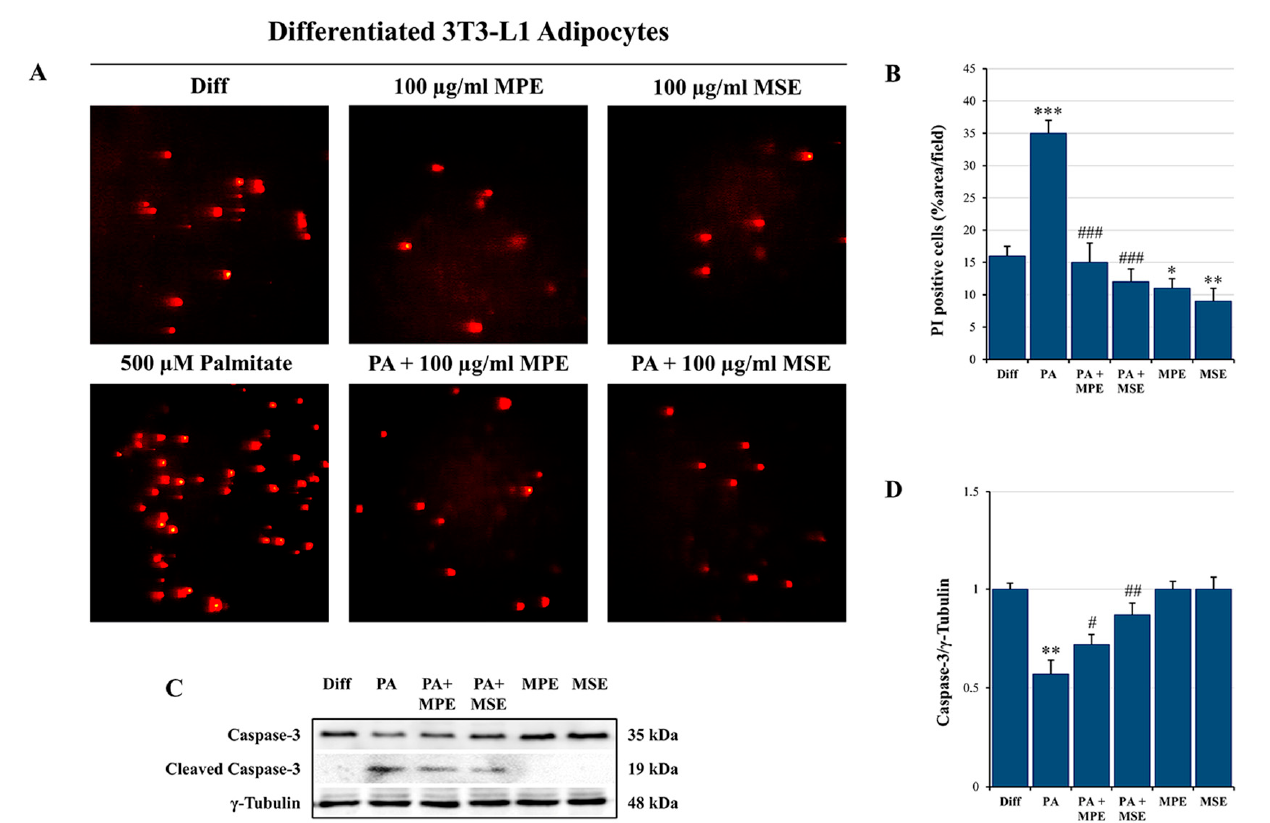
Figure 7. MPE and MSE reduce the cytotoxic effects of PA in 3T3-L1 adipocytes. Propidium iodide (PI) staining of differentiated 3T3-L1 adipocytes treated with 500 µ M PA for 48 h in the presence or absence of 100 µ g/mL MPE or MSE. ( A ) Representative fluorescence microscopy images were taken at 200 × magnification by a Leica microscope equipped with a DC300F camera using a PE filter. ( B ) PI content was ascertained by analyzing the percentage area with Image J. ( C ) Western blotting analysis of the procaspase-3 levels. An equal loading of protein (30 µ g) was verified by immunoblotting for γ -Tubulin ( D ). The bar graphs represent the means of three independent experiments ± SD. * p < 0.05, ** p < 0.01 and *** p < 0.001 with respect to differentiated 3T3-L1 adipocytes. # p < 0.05, ## p < 0.01, ### p < 0.001 were significant with respect to PA-treated 3T3-L1 adipocytes. The cytotoxic effects induced by PA in adipocytes seem to be related to apoptosis induction. Pro-caspase-3 is a master apoptosis protein marker cleaved in active form during this process [56]. PA treatment decreased the level of pro-caspase-3 by 43% (Figure 7C,D) and promoted the appearance of the cleaved active form of caspase-3. Notably, caspase activation was counteracted by the addition of MPE or MSE (Figure 7C,D). Our previous studies provided evidence that MPE and MSE contain factors capable of exerting ROS scavenger effects during 3T3-L1 adipocyte differentiation [43]. These effects have been correlated with the ability of mango extracts to increase Nrf2, the main antioxidant tran- scription factor [57], during adipocyte differentiation [43]. In accordance with our previous data, we demonstrated that in PA-treated adipocytes, MPE or MSE increased the level of Nrf2 by about 40% and 60%, respectively (Figure 8). Our data also showed that the levels of MnSOD and HO-1, two scavenger enzymes transcriptionally regulated by Nrf2 [57,58], markedly increased after treatment with MPE or MSE. In particular, the increase in MnSOD in the presence of MPE or MSE was estimated to be 46% and 50%, while that of HO-1 was estimated to be 12% and 28%,